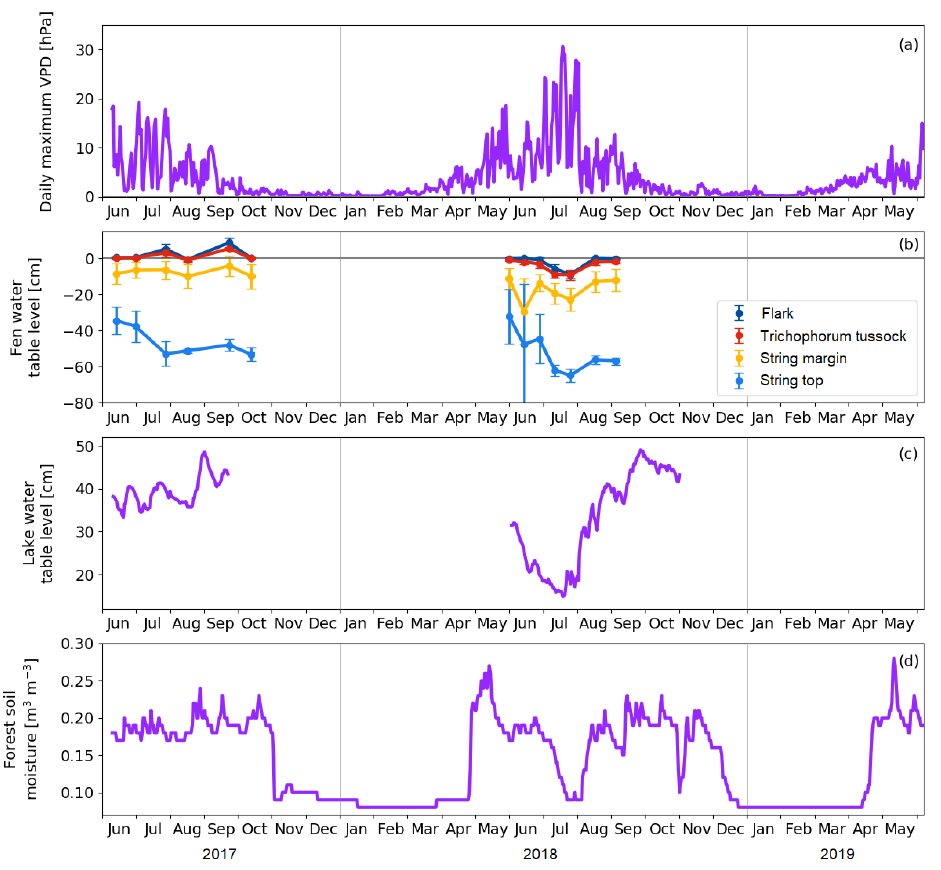
Figure 6. (a) Daily maximum vapour pressure deficit. (b) Mean water table level at the main plant communities of the fen. Error bars represent the standard deviation. (c) Water table level at the floating chamber position in Lake Jänkälampi. (d) Forest soil moisture at 10cm depth.